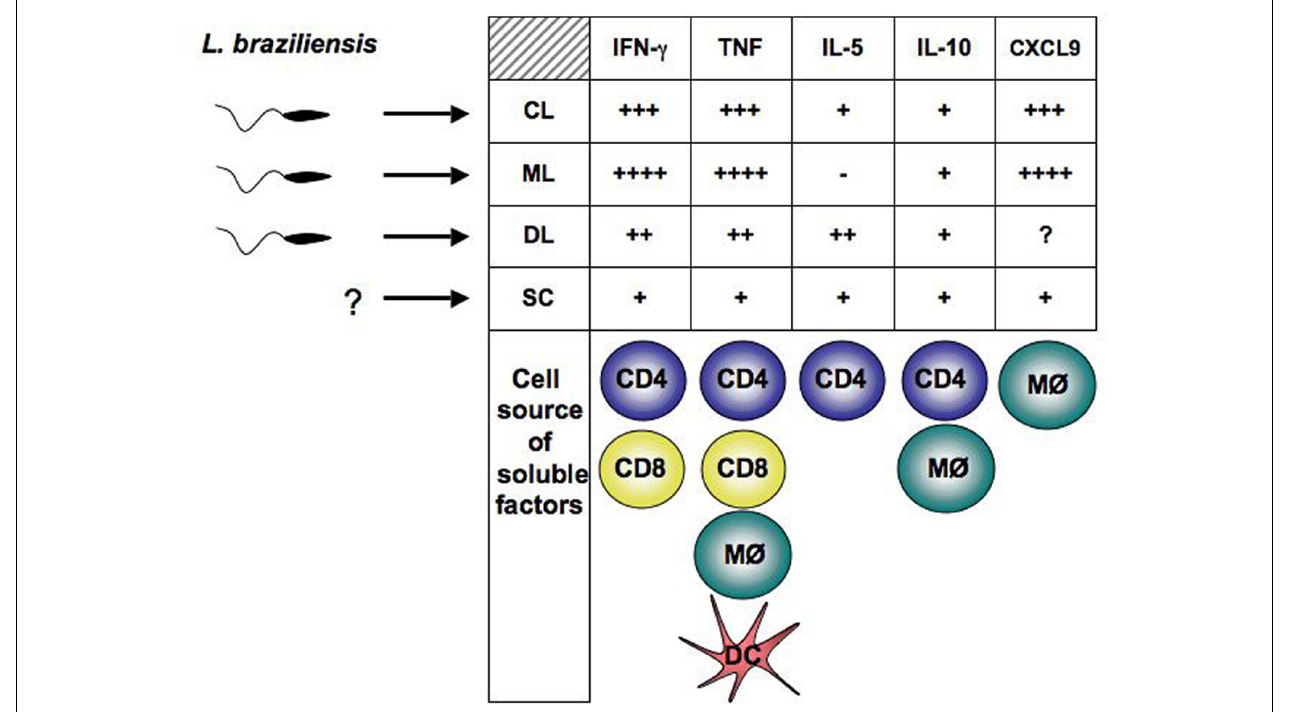
achieved. Exaggerated pro-inflammatory immune response leads to tissue damage and ulcer development. Cells known to contribute to cytokines and CXCL9 production in L. braziliensis -infected patients are represented below the corresponding soluble factor. CL, cutaneous leishmaniasis; ML, mucosal leishmaniasis; DL, disseminated leishmaniasis; SC,